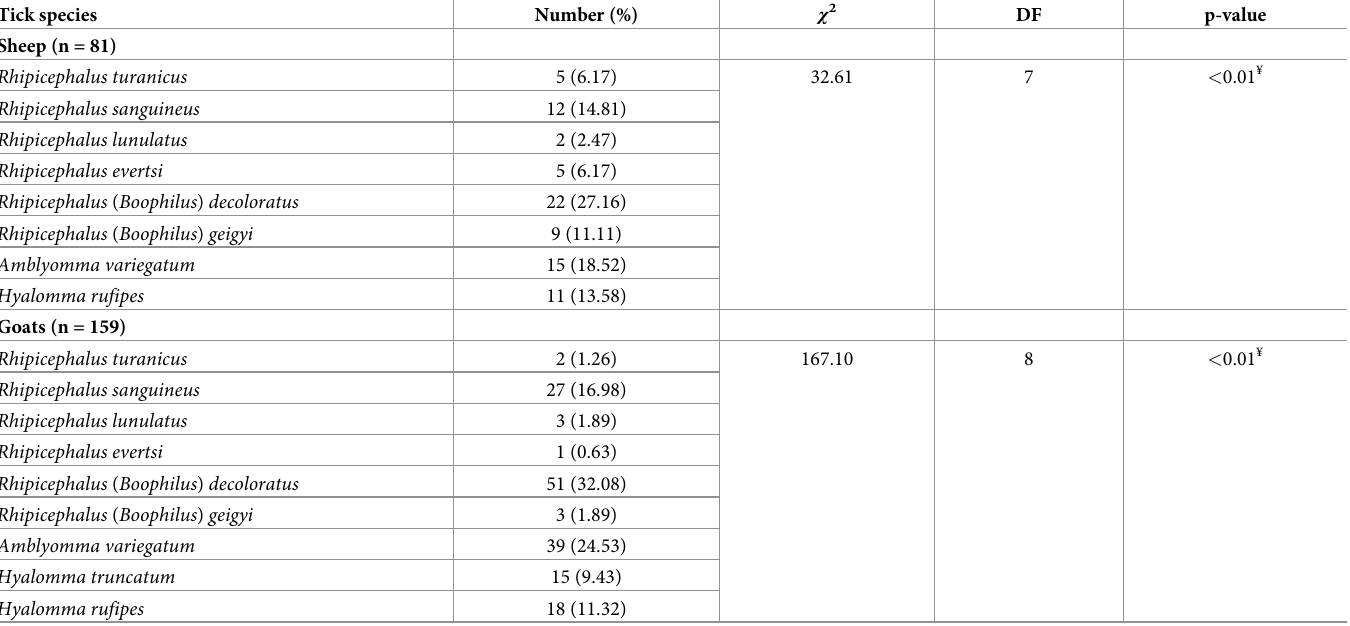
Table 3. Diversity and prevalence of tick species infesting small ruminants in Ilorin,